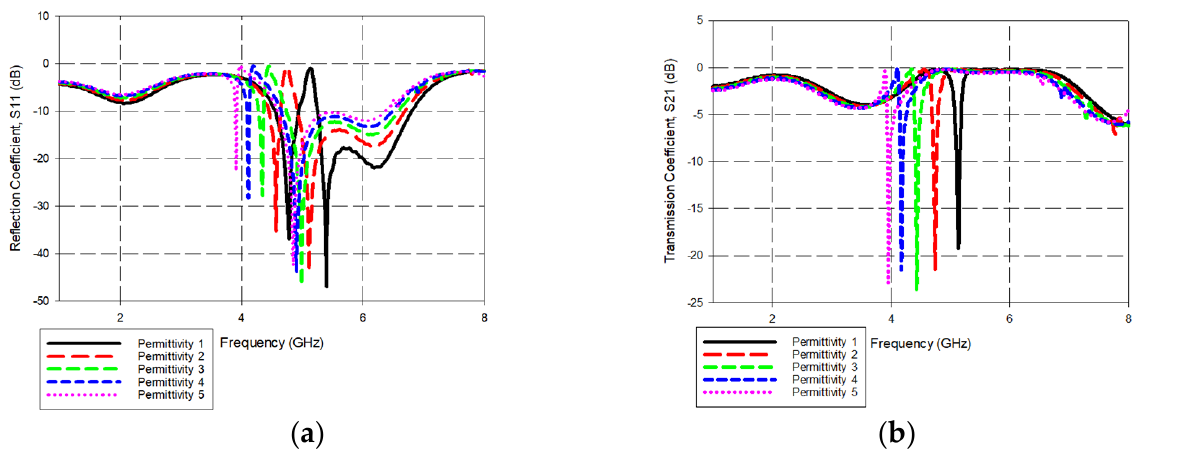
Figure 15. Shifting in resonance of ( a ) reflection coefficient (S11) and ( b ) transmission coefficient when simulated with a range of 1 − 5 dielectric constant.